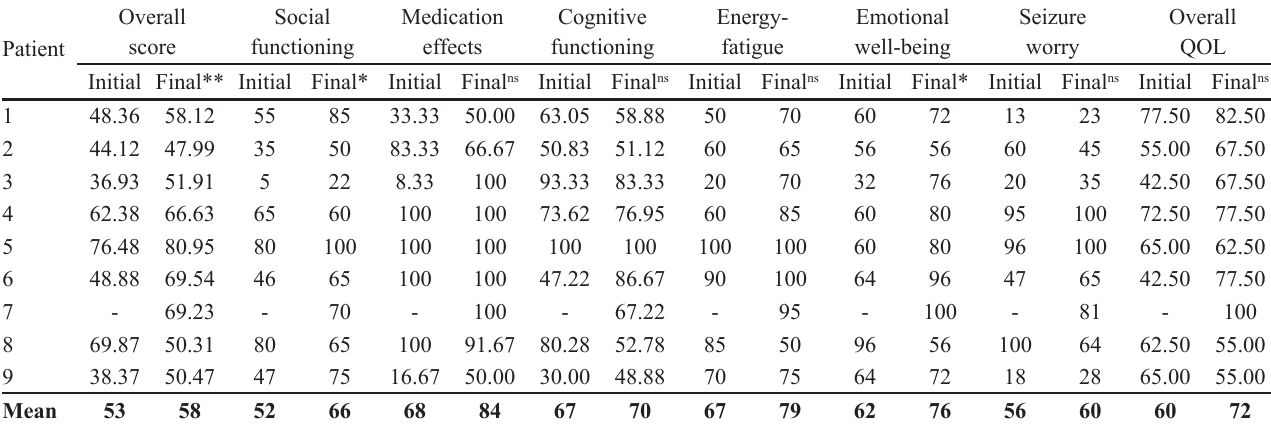
TABLE I - Results (initial versus final) on the QOLIE-31 (total and domains) for formulation A